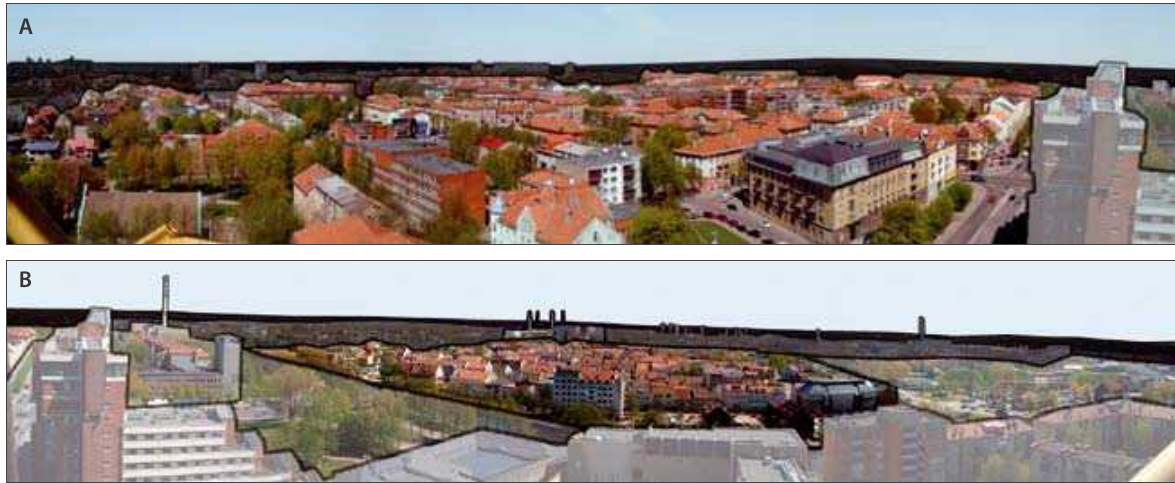
Fig. 8. View points “from inside to outside” from buildings “k” and “D” where the view is perceived step by step: A – to the new-town; b – to the Old-town